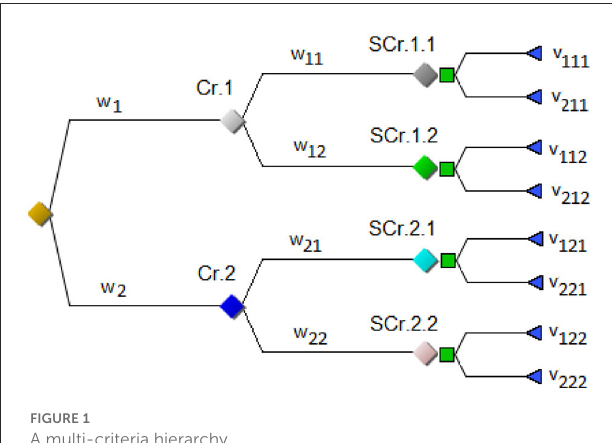
FIGURE1 A multi-criteria